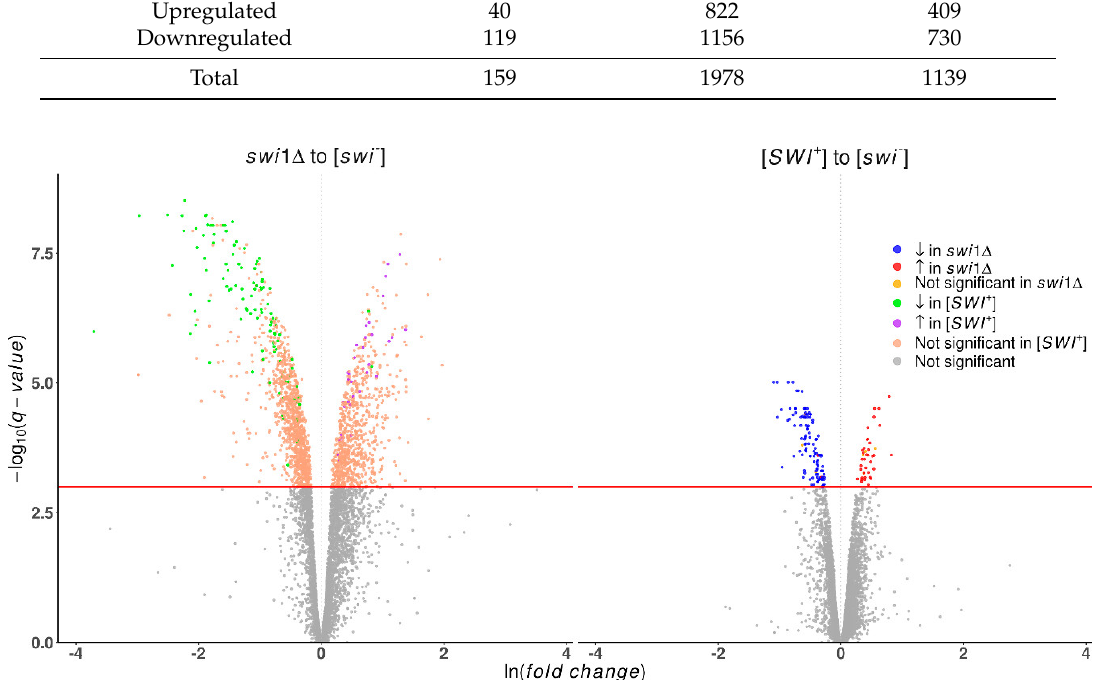
Figure 1. Volcano plots demonstrating differentially expressed genes in the swi1 Δ and [ SWI + ] compared with [ swi − ] strains. Plotted on the x -axis is the ln fold difference between [ swi − ] and the corresponding strain. Plotted on the y -axis is the −log10(q-value) calculated with R package Sleuth [51]. Genes whose expression changes are nonsignificant are shown in gray below the red line, while significant differentially expressed genes (FDR < 0.001) are divided into categories, as follows. On the plot comparing swi1 Δ to [ swi − ], green indicates genes significantly downregulated in [ SWI + ], purple represents genes significantly upregulated in [ SWI + ], and pink signifies genes which are nonsignificant in the comparison of [ SWI + ] to [ swi − ]. On the plot of [ SWI + ] to [ swi − ], genes downregulated in swi1 Δ are shown blue, those upregulated in swi1 Δ are red, and those which are nonsignificant in the comparison of swi1 Δ to [ swi − ] are yellow.